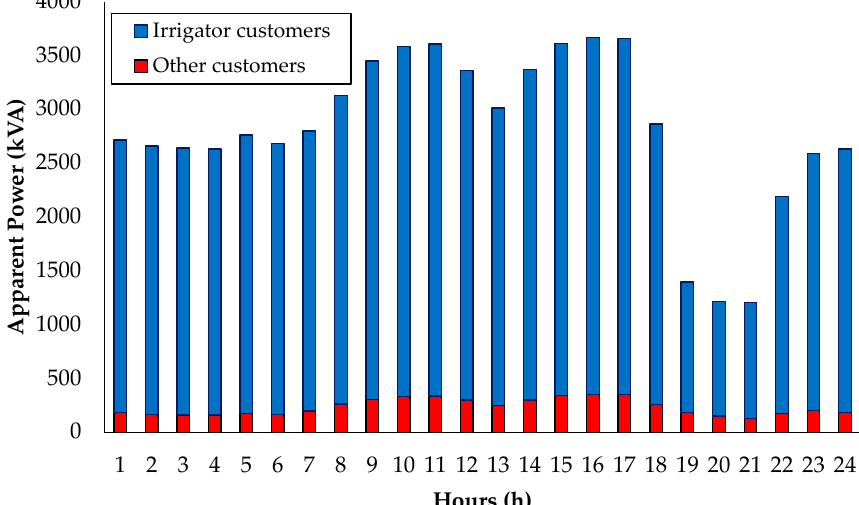
Figure 17. Load distribution on Rural Feeder B. Source: The authors.